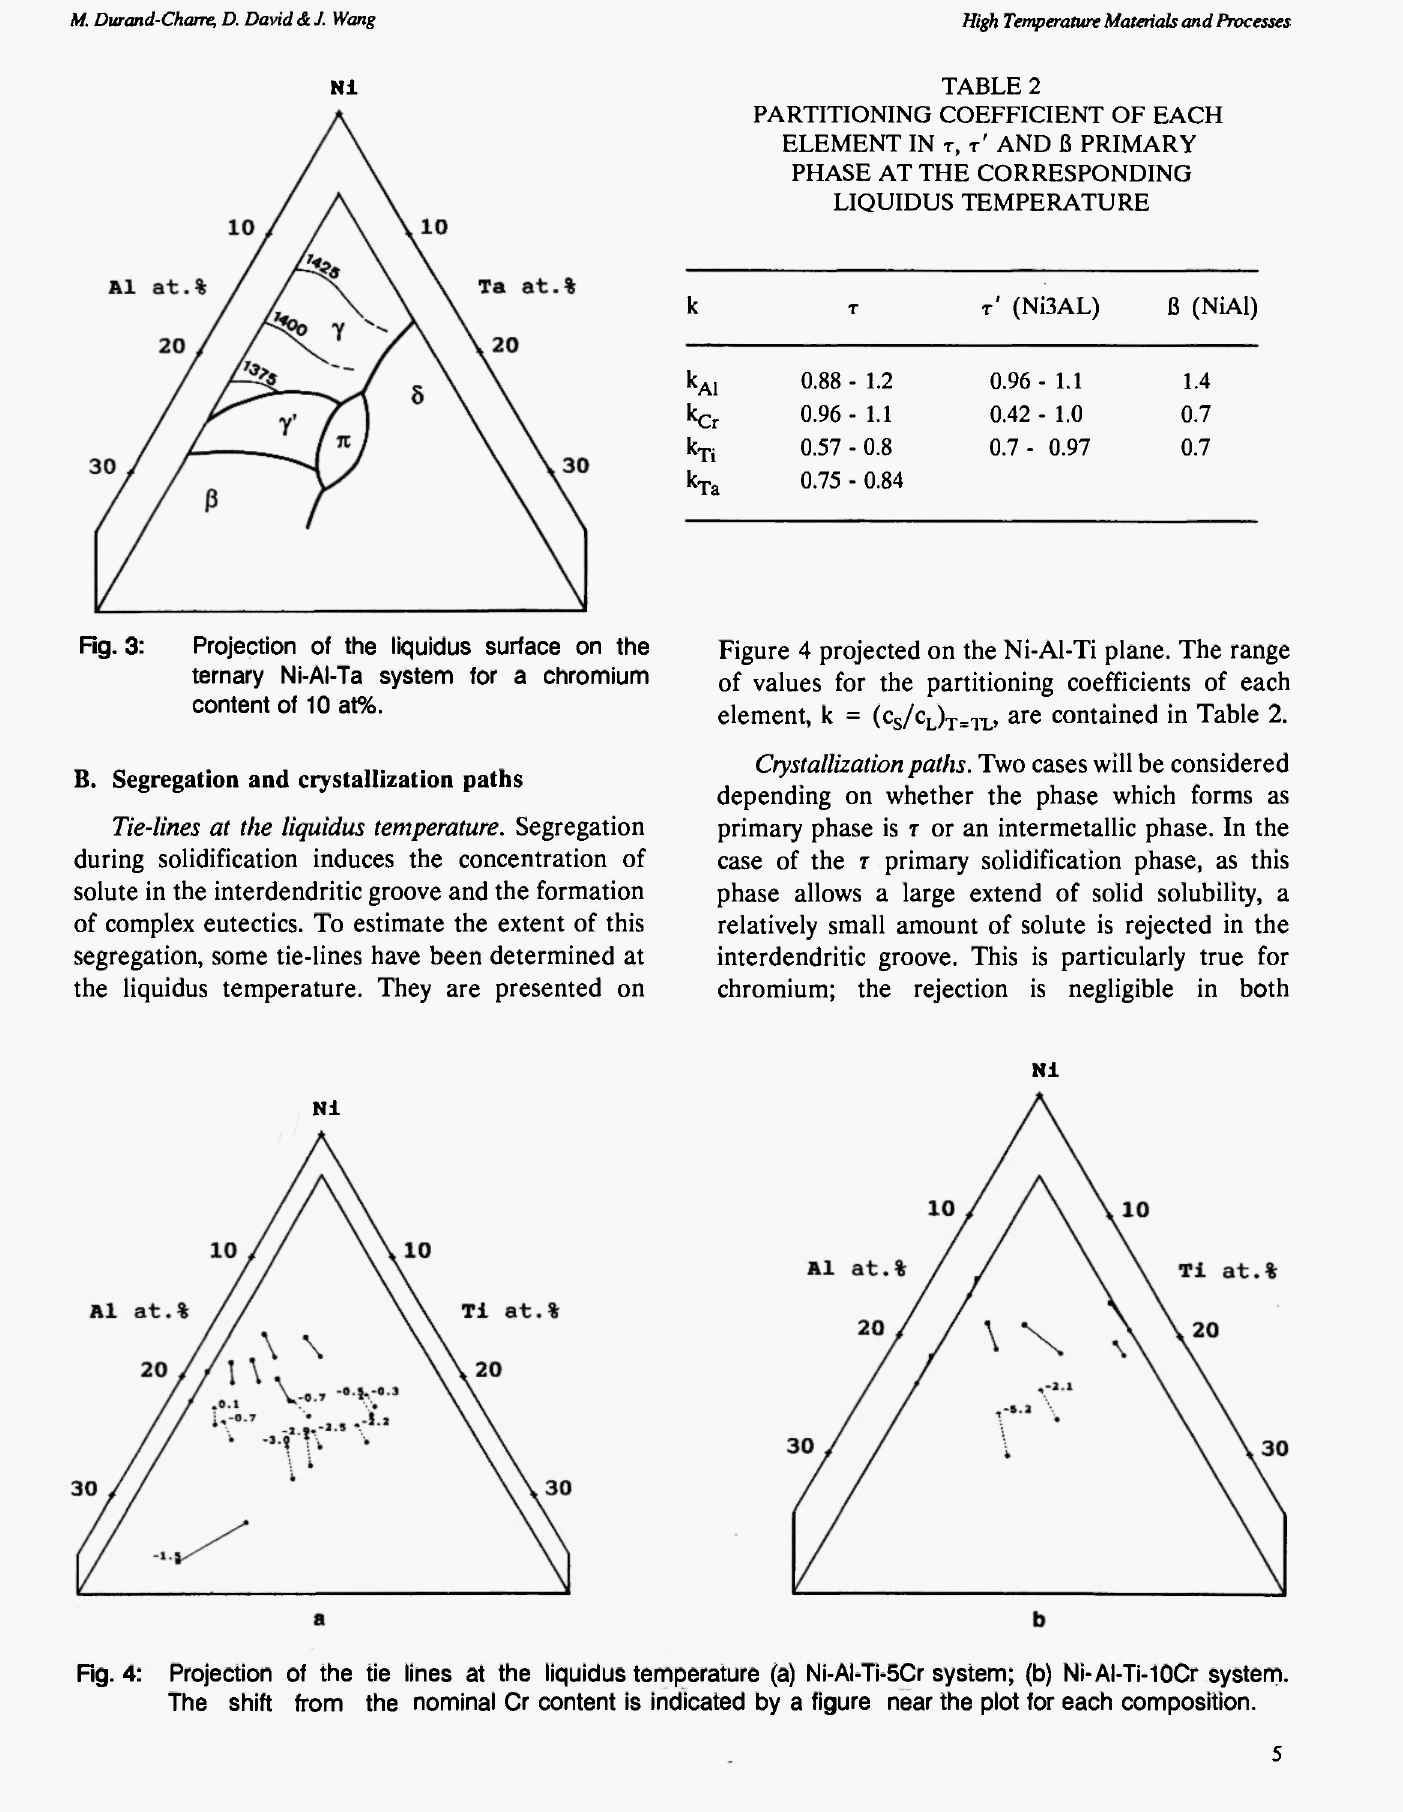
Fig. 4: Projection of the tie lines at the liquidus temperature (a) Νi-AI-Ti-5Cr system; (b) Ni-AI-Ti-10Cr system. The shift from the nominal Cr content is indicated by a figure near the plot for each